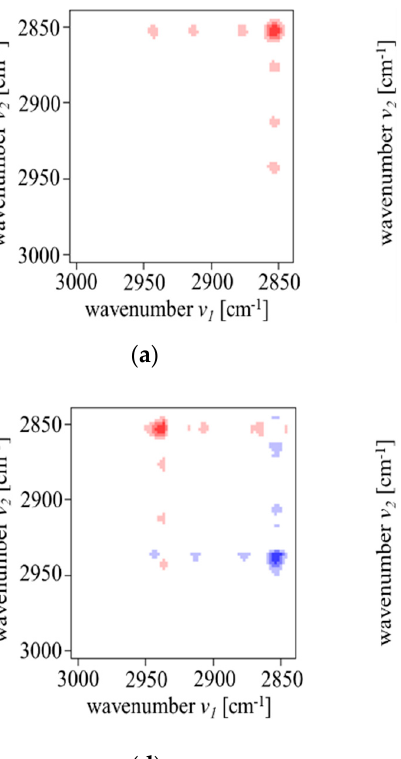
( c ) Figure 5. Perturbation-correlation moving window two-dimensional analysis (PCMW2D) correlation synchronous maps in the cooling mode of 3F7HPhH7 in the wavenumber regions of: ( a ) 3100–2800 cm –1 , ( b ) 1800–1400 cm –1 and ( c ) 1400–1000 cm –1 . The red or blue areas represent positive or negative correlation intensities, respectively. Figure 6 presents the 2D-COS correlation maps, obtained during the cooling in the temperature region from 349 to 259 K in the wavenumber regions of ν (C–H) (at 3100–2800 cm –1 ) vibrations, in Figure 6a, ν (C=O) (at 1800–1580 cm –1 ) vibrations, in Figure 6b, and ν (C–O–C) (at 1520–1050 cm –1 ) vibrations, in Figure 6c. Both synchronous and asynchronous maps are plotted on a plane between two independent wavenumber axes. For all analyzed bands (except the ν (C–H) asym (at 2936 cm –1 ) band), the auto-peaks have been observed on the synchronous maps. The positive synchronous cross-peaks for ν (C–H) asym (at 2936 cm –1 ), ν (C–H) sym (at 2858 cm –1 ), ν (C–O–C) asym (at 1283–1264 cm –1 ) and ν (C–O–C) asym (at 1185–1172 cm – 1 ) bands were visible, indicating that these bands’ intensities simultaneously increase or decrease upon cooling (Figure 6a,c). On the other hand, the negative synchronous cross-peaks for ν (C=O) core